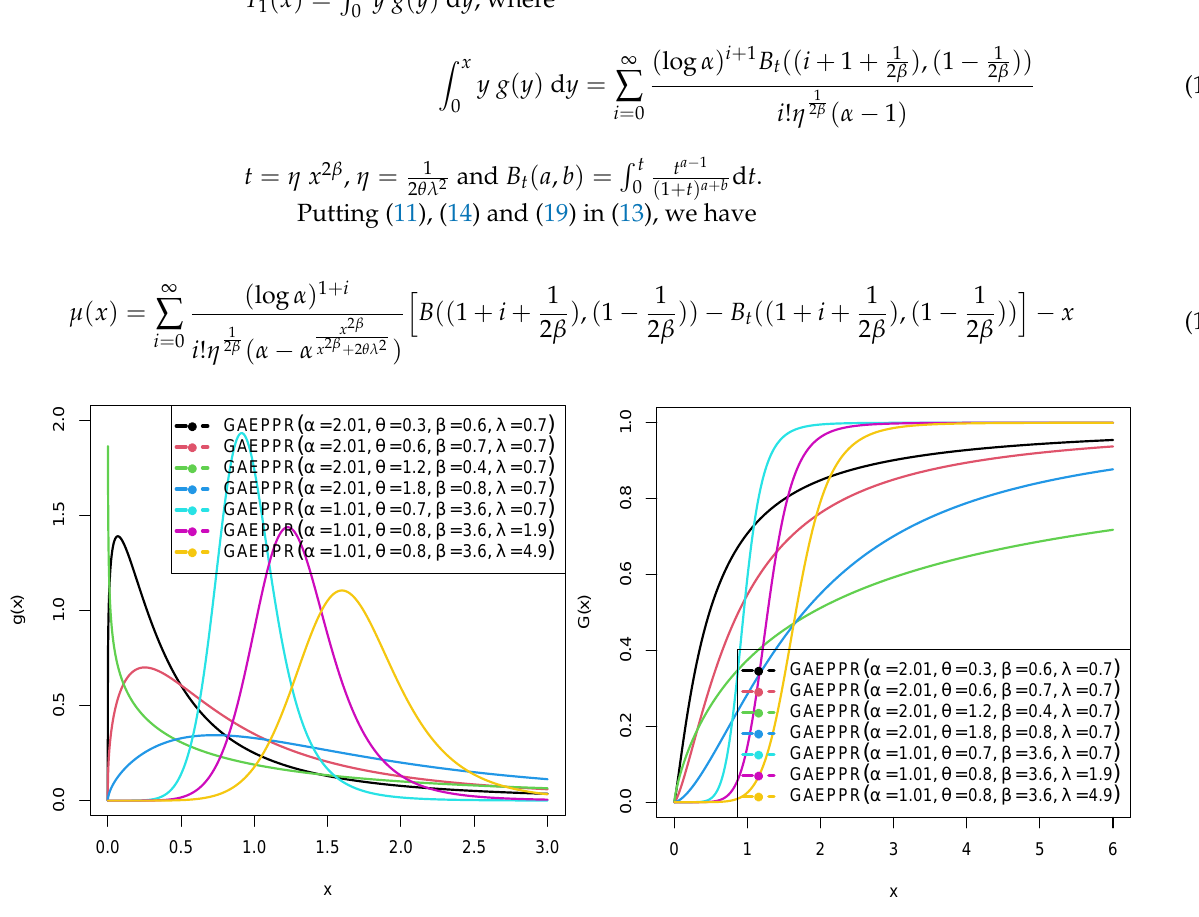
Figure 1. The p.d.f and CDF plots of the